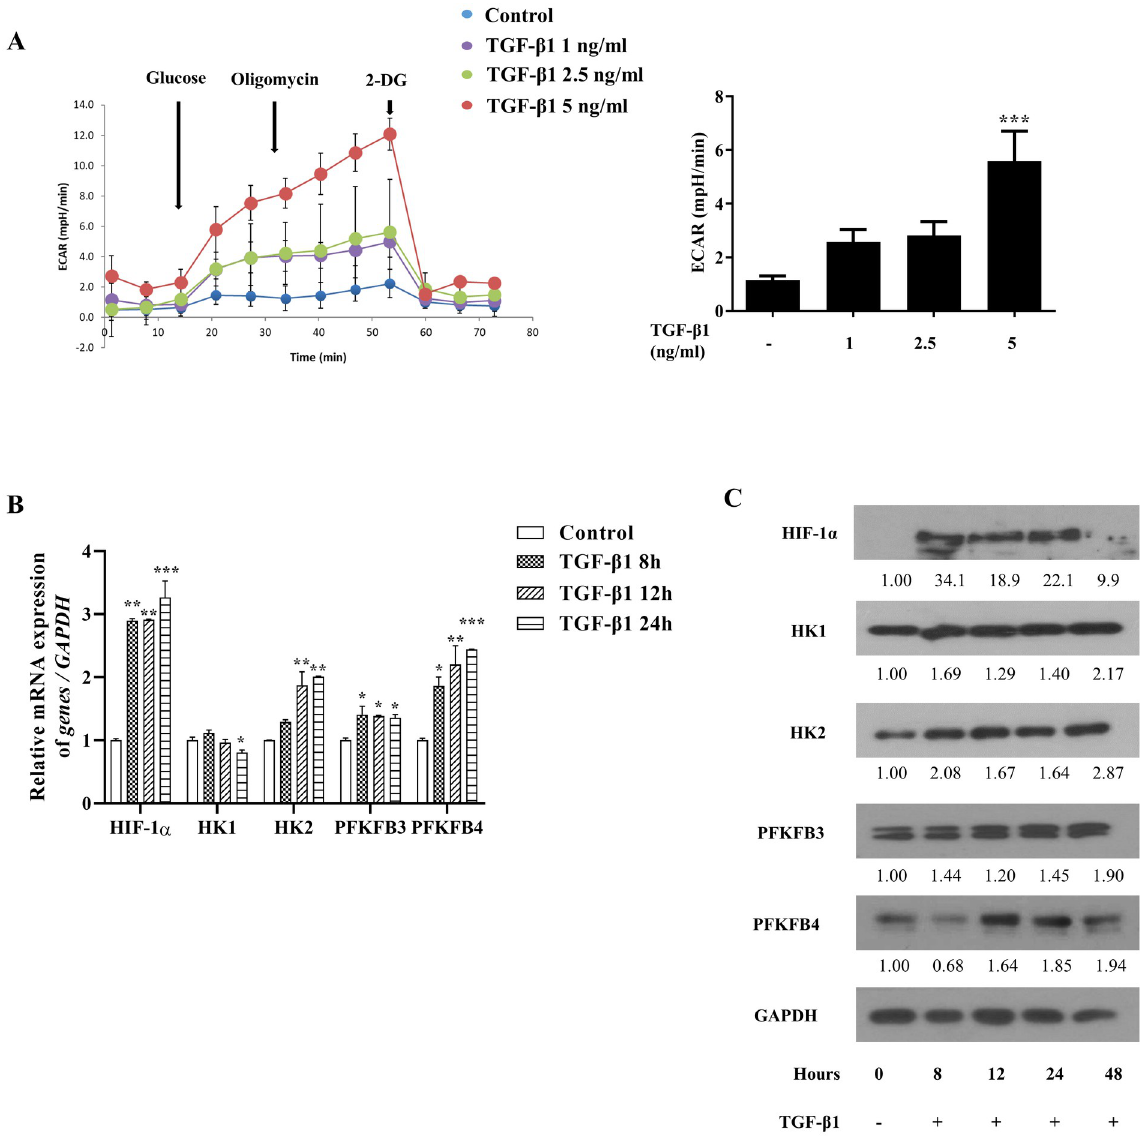
Fig 1. Glycolytic rate, hypoxia inducible factor (HIF)-1 α , and glycolytic enzymes were upregulated in transforming growth factor (TGF)- β 1-treated nasal fibroblast. (a) Extracellular acidification rate (ECAR) of fibroblast treated with or without TGF- β 1 was measured using XFe96; (b) Gene expression of HIF-1 α , hexokinase (HK) 1, HK2, 6-phosphofructo-2-kinase/fructose-2,6-bisphosphatase (PFKFB) 3, and PFKFB4 were confirmed by RT-PCR; and (c) protein levels were detected by Western blotting. � p < 0.05, �� p < 0.01, ��� p < 0.001 compared with the control using one-way ANOVA